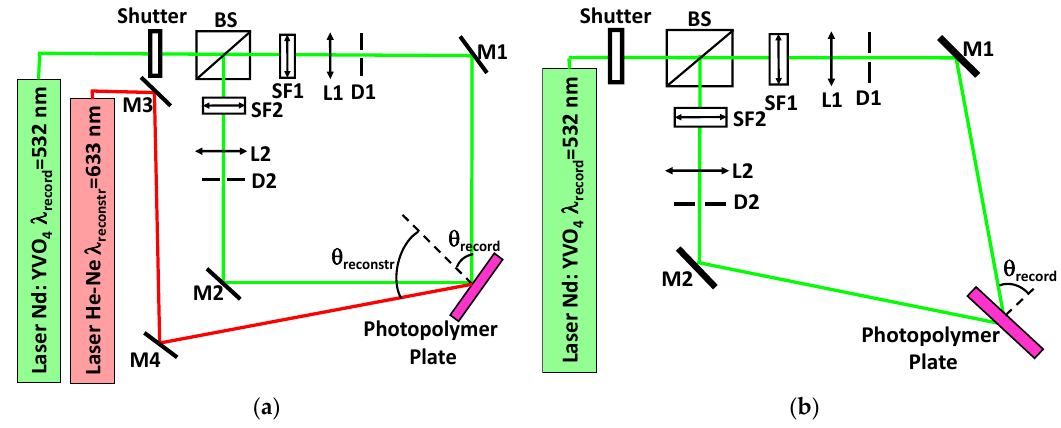
Figure 3. ( a ) Experimental setup for transmission gratings; ( b ) experimental setup for reflection gratings. Mi: mirrors, BS: beam splitter, Li: lenses, SFi: microscope objective lens and pinhole, Di: diaphragms, record is the angle with which the recording laser beams impinge in the material, reconstr is the angle with